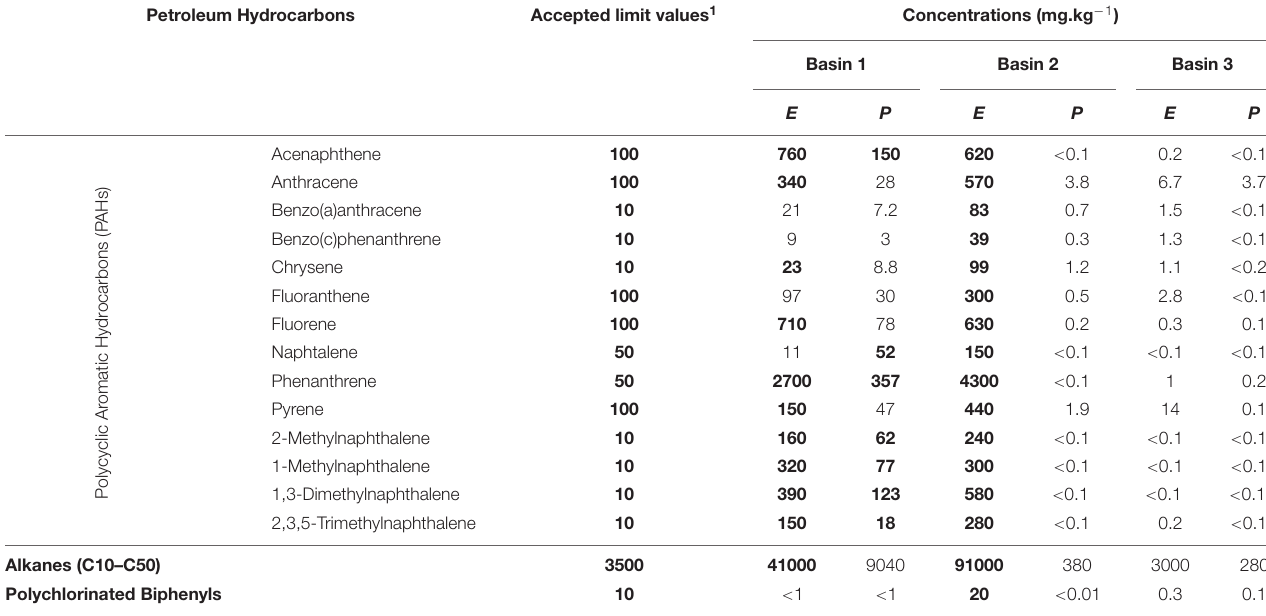
TABLE 1 | Concentrations of petroleum hydrocarbon pollutants (polycyclic aromatic hydrocarbons (PAHs) (Chaudhry et al., 2005), alkanes [C10–C50] and total polychlorinated biphenyls [PBCs]) in the sediments of the three basins where Eleocharis erythropoda (E) and Populus balsamifera (P) plants were